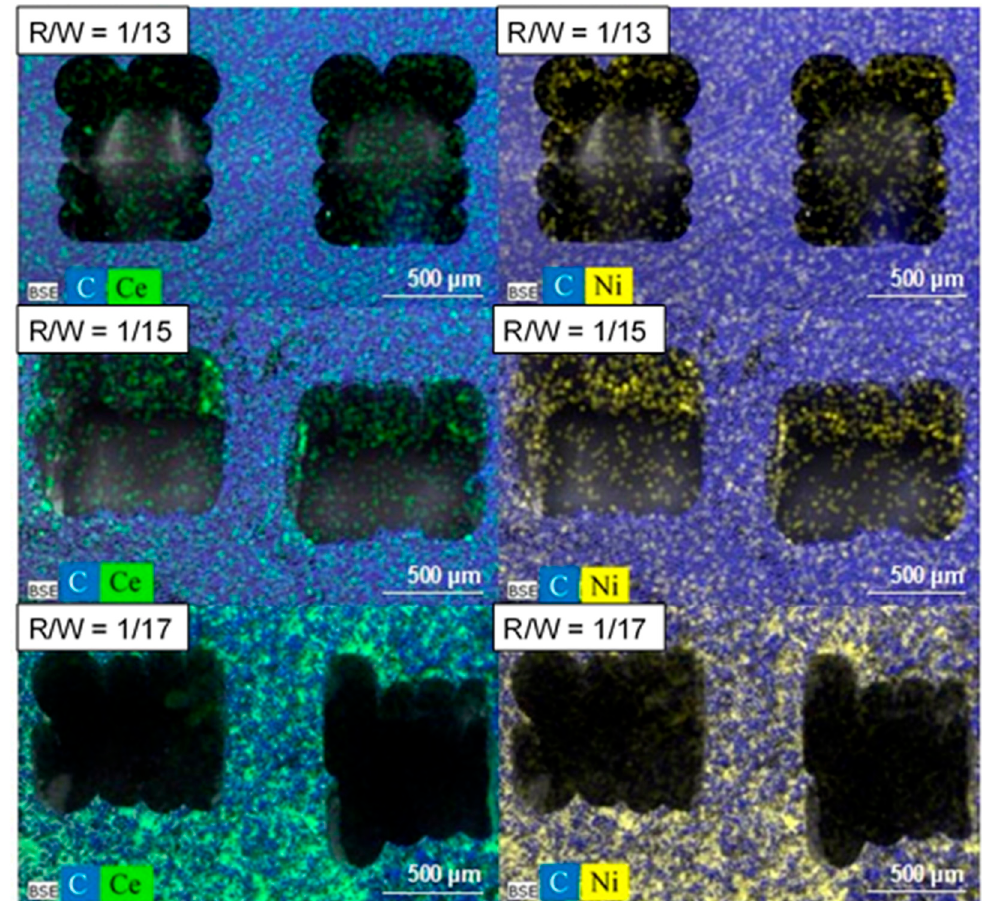
Figure 5. Chemical mapping of the Ni/CeO 2 catalyst deposited on conventional carbon monoliths prepared with different R/W molar ratio. Left : C (blue) and Ce (green) and Right : C (blue) and Ni (yellow) elements.